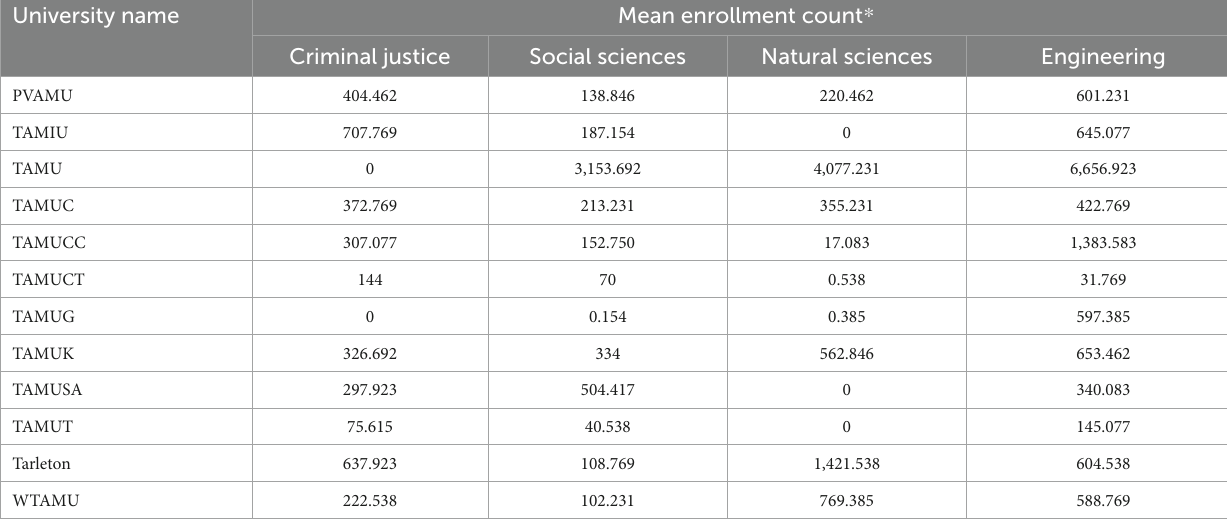
TABLE 4 Mean enrollment counts for each program type under the study across all universities from 2009 to